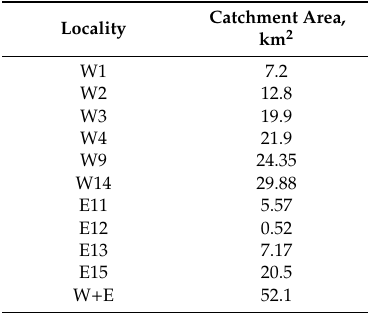
Table 5. Catchment areas.